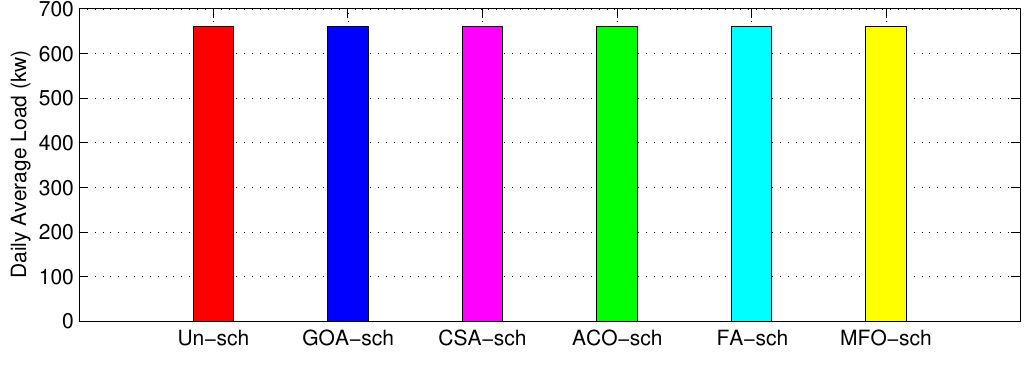
Figure 9. The total daily average